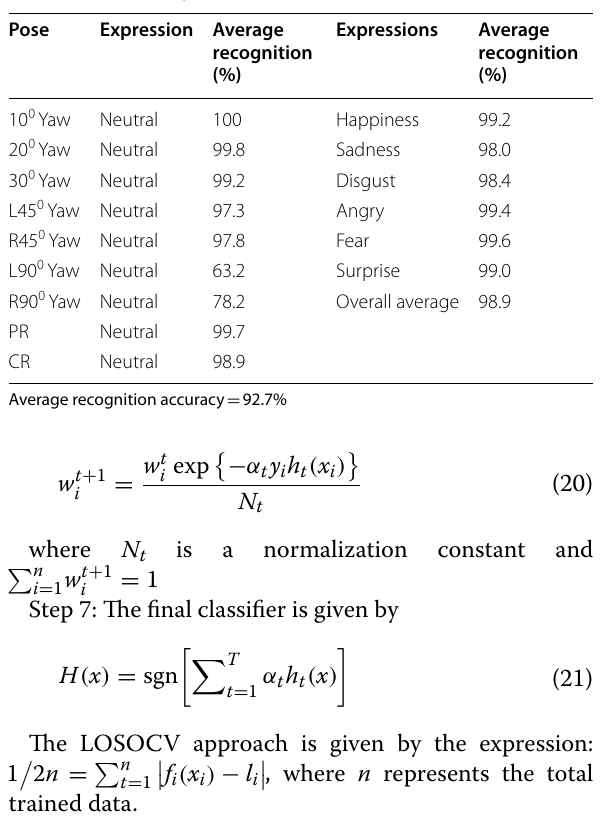
Table 1 FER in Bosphorus database